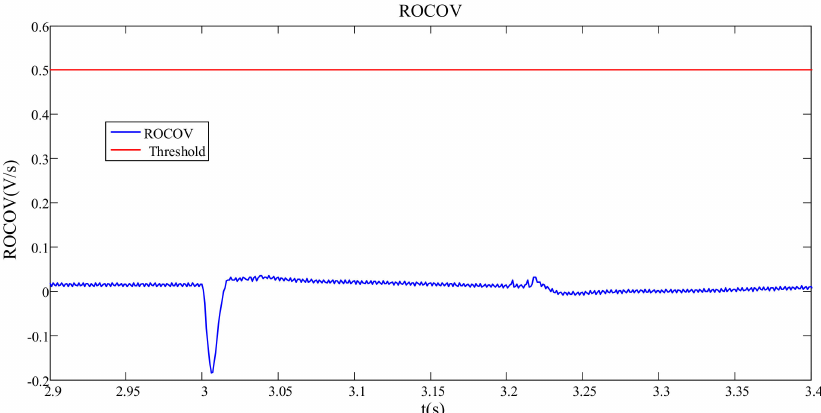
Figure 13. The output of ROCPAD relay in short circuit fault.